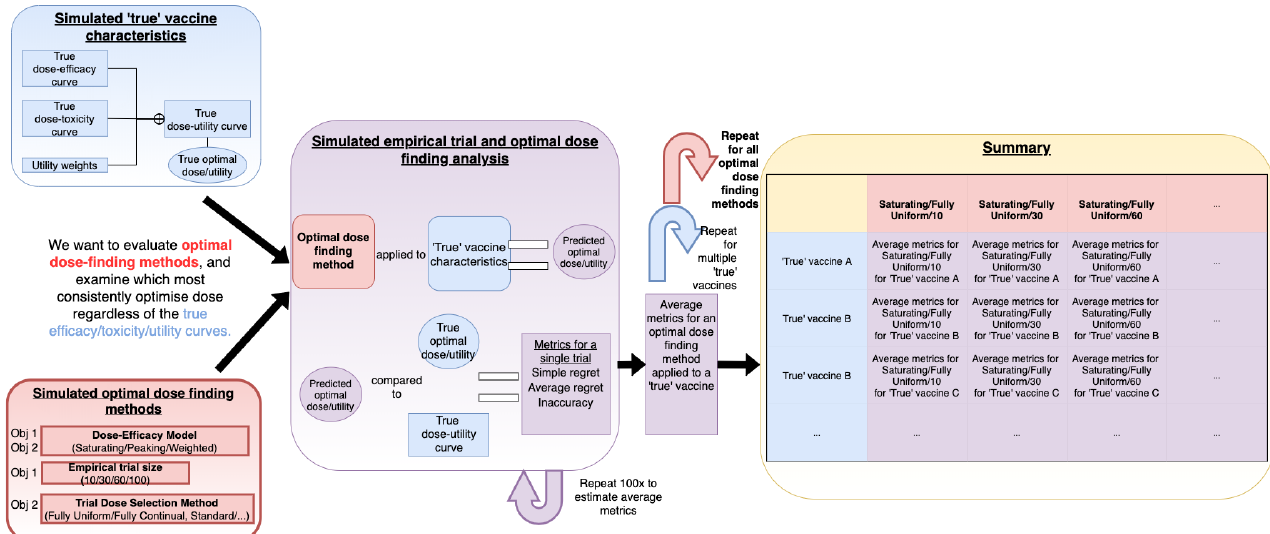
Figure 1. Visual depiction of the process of conducting simulation studies used in this work to assess mathematical-modelling-based dose-optimisation approaches. The aim was to evaluate dose-optimisation approaches (red), in particular the effect of changing the assumed dose–efficacy model, trial size, and trial dose-selection method. These were tested by simulating clinical trials (purple) based on ‘scenarios’ (blue). Repeated simulation of clinical trials was conducted for different dose-optimisation approach/scenario pairs, and metrics related to how effectively optimal dose was located were calculated. These were tabulated and compared to assess whether the assumed dose – efficacy model, trial size, and trial dose-selection method influence the consistency of dose optimsation.